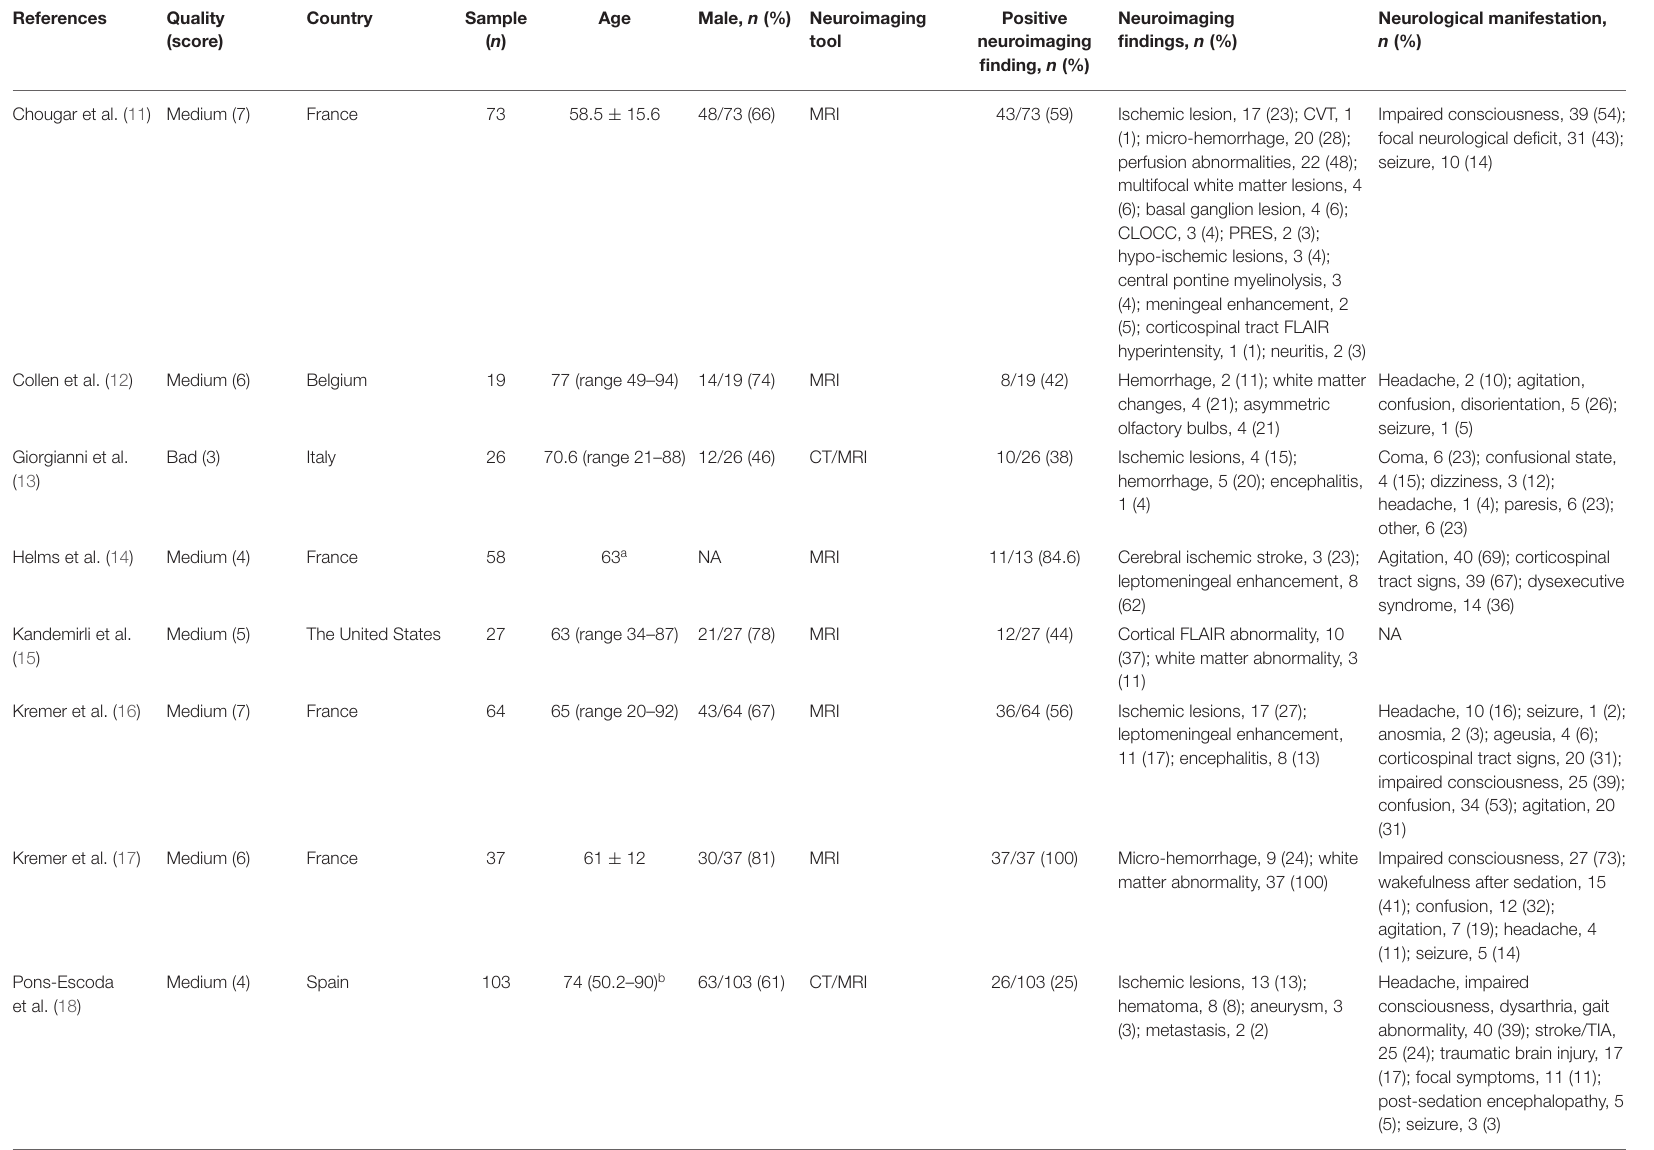
TABLE 1 | Characteristics of included studies for quantitative